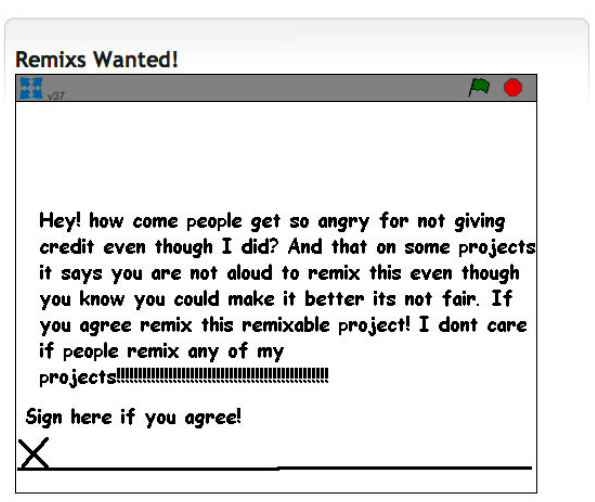
Figure 9. A project “petition” to call on supporters of remixing in the Scratch community.